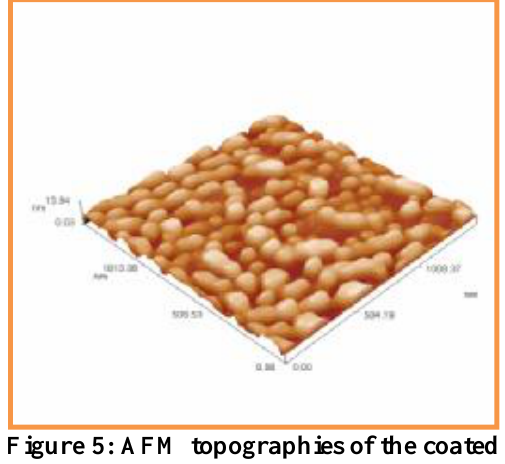
Figure 5: AFM topographies of the coated surface